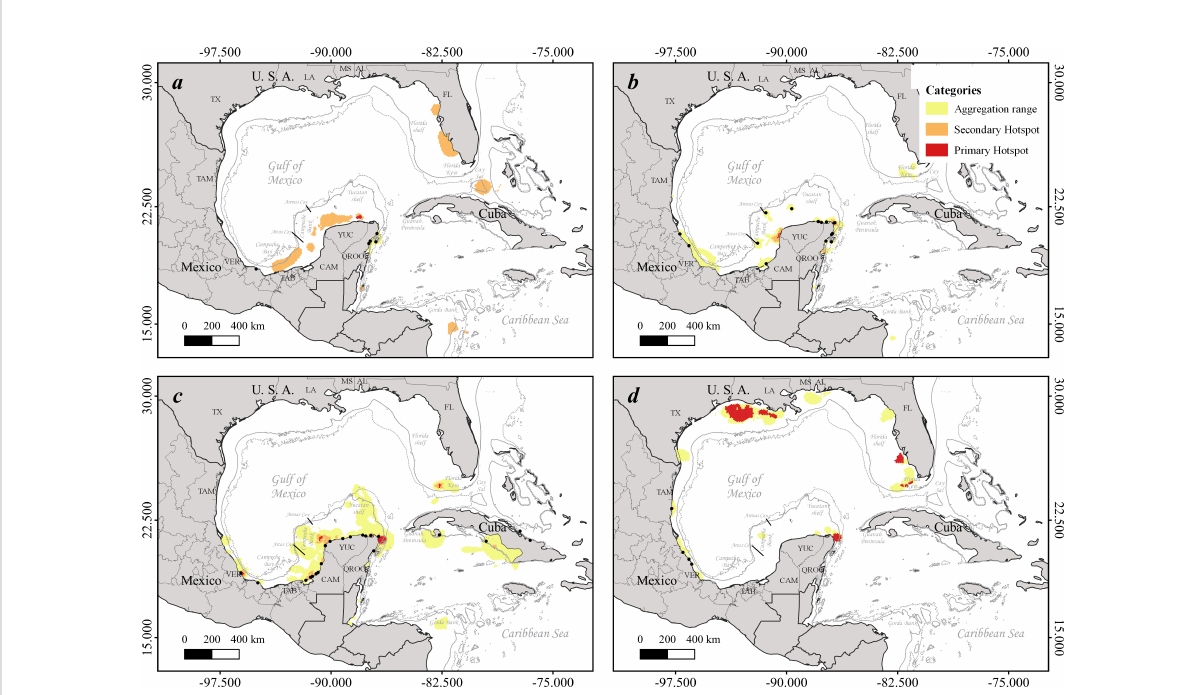
FIGURE 1 Aggregation hotspots for breeding female marine turtles, integrated with the internesting and feeding/residency movement phases. We present three hotspot categories for C. caretta ( A , n=10), C. mydas ( B , n=65), E. imbricata ( C , n=79), and L. kempii ( D , n=24). Continuous thin gray line depicts the 200 m isobath, and the dashed thin line depicts the 500 m isobath (https://www.gebco.net/). Black dots represent the releasing sites of the satellite- tracked